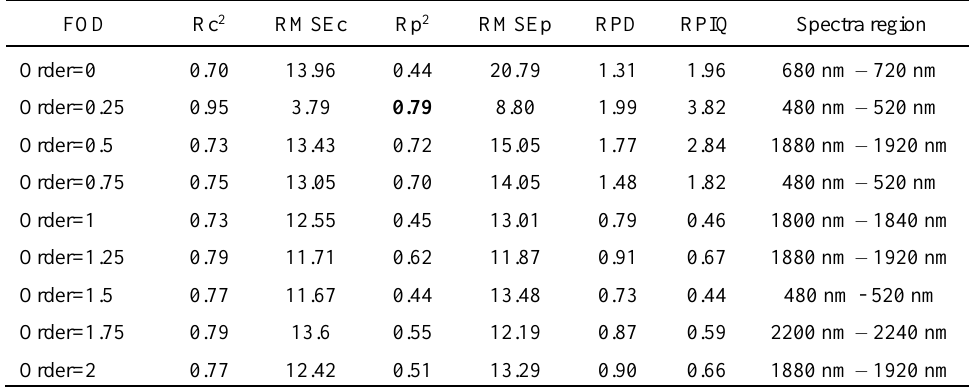
Table 1. Results of the estimation between Cr and the best spectra interval